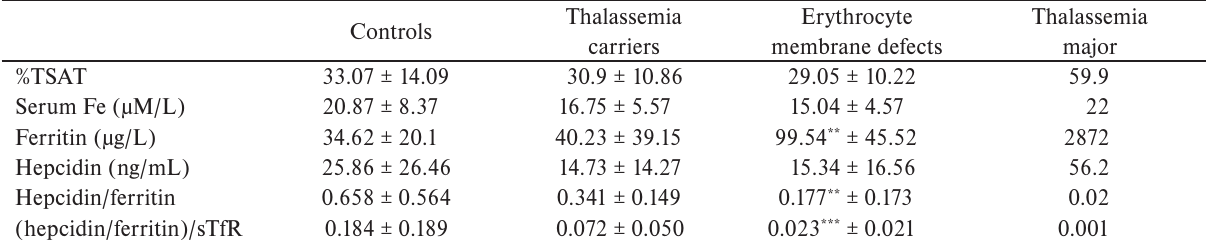
Table 3. Iron status